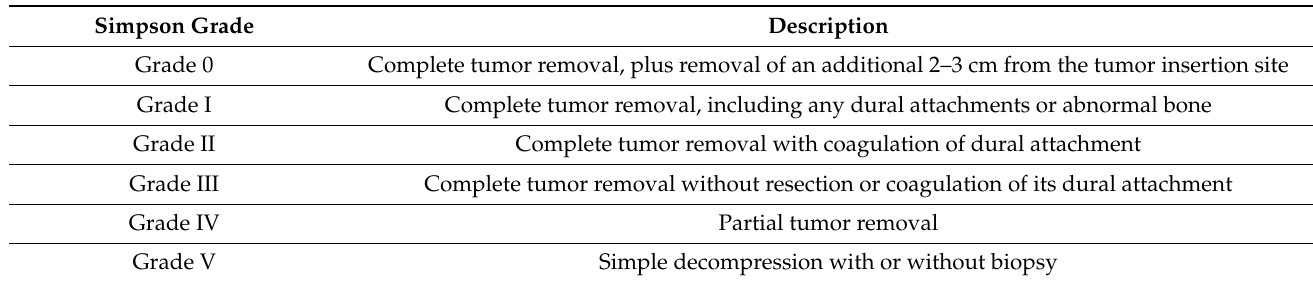
Table 1. Simpson grading for extent of meningioma